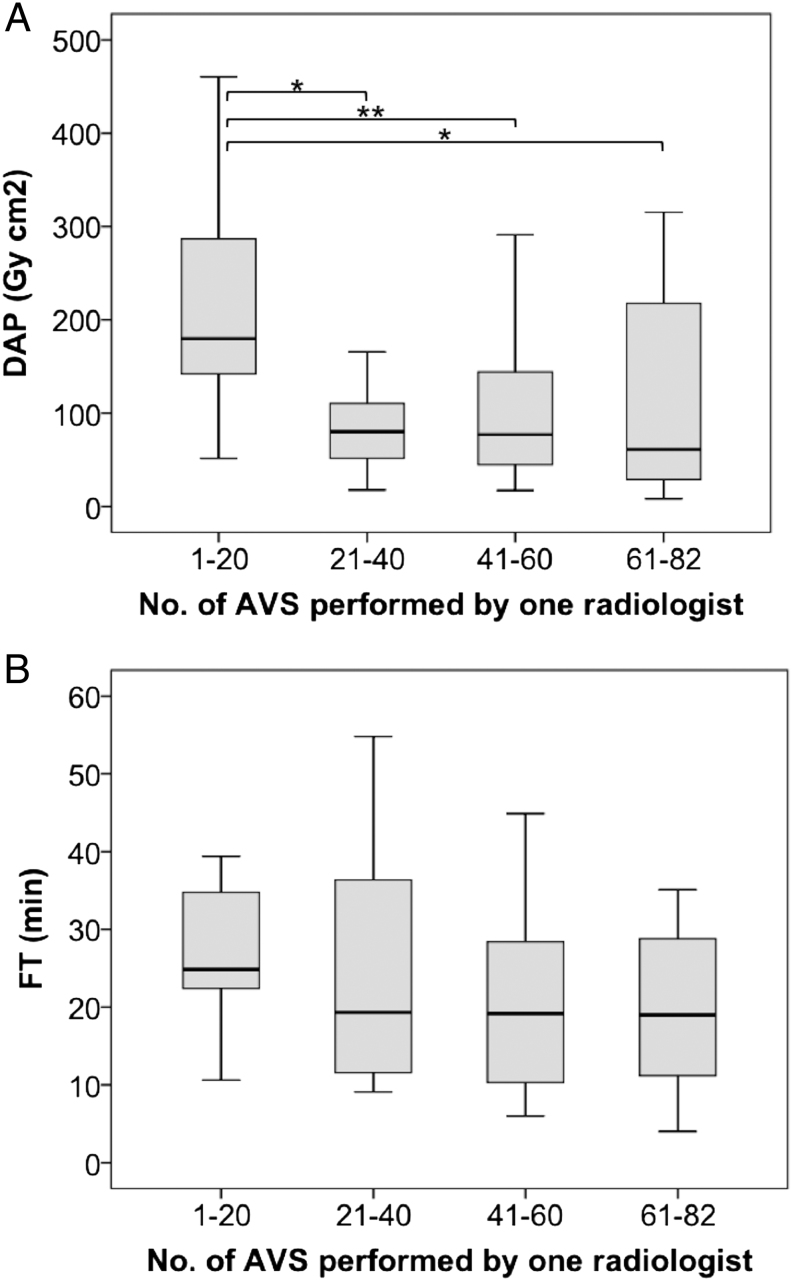
Changes in dose area product (DAP, Gy*cm2) and fluoroscopy time (FT, min) over time depending on the number of AVS performed by a single radiologist at center 4 (n = 82). x-axis = number of AVS in groups of 20 (22) AVS. (A) DAP, 1–20: 180 (52–461); 21–40: 80 (18–339); 41–60: 77 (17–291); 61–82: 61 (8.2–315); 1–20 vs 21–40 P = 0.011; 1–20 vs 41–60 P = 0.008; 1–20 vs 60–82 P = 0.013. (B) FT, 1–20: 25 (11–86); 21–40: 19 (9.1–55); 41–60: 19 (6.0–45); 61–82: 19 (4.0–81). *P ≤ 0.05, **P ≤ 0.01.